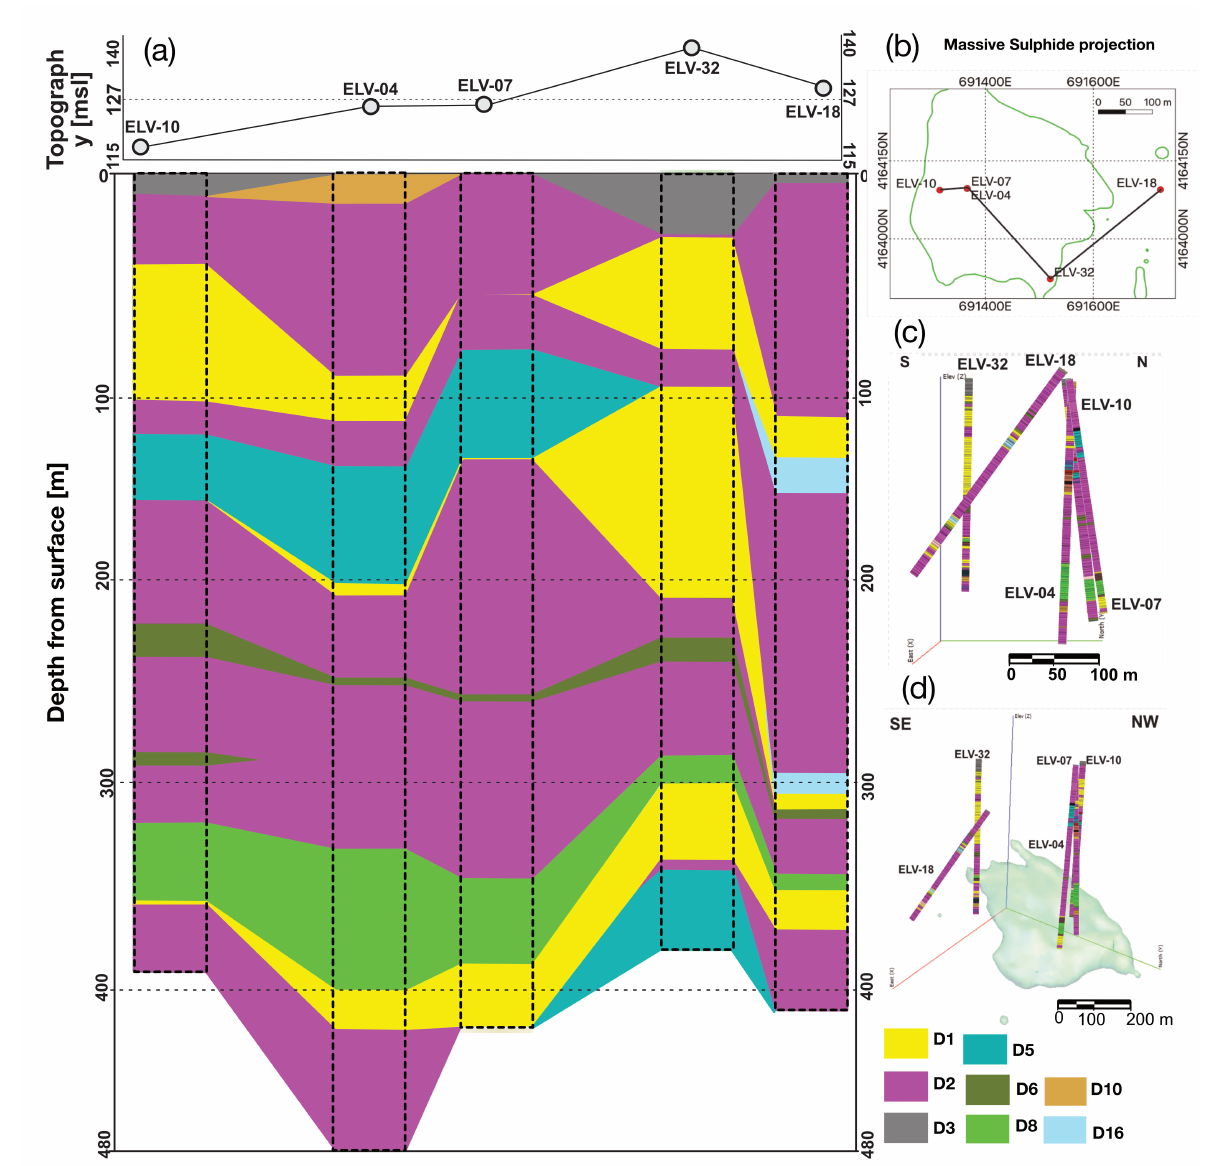
Figure 11. ( a ) Manual interpretation of the E-W cross-section (Figure 9b) with geological domains derived from the hyperspectral data by the proposed methodology extracted at a scale of 45. ( b ) Base map from the Elvira site, showing the cross-section profile and surface projection of the massive sulphide lens. ( c ) 3D visualization of the boreholes utilized in the profile. ( d ) 3D visualization of the boreholes utilized in the profile together with an enveloping surface of the massive